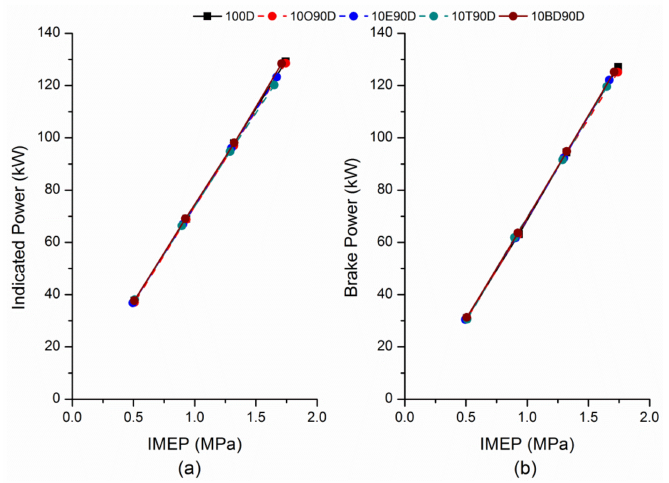
Figure 3. Power variation of tested fuel blends: ( a ) Indicated ( b ) Brake.